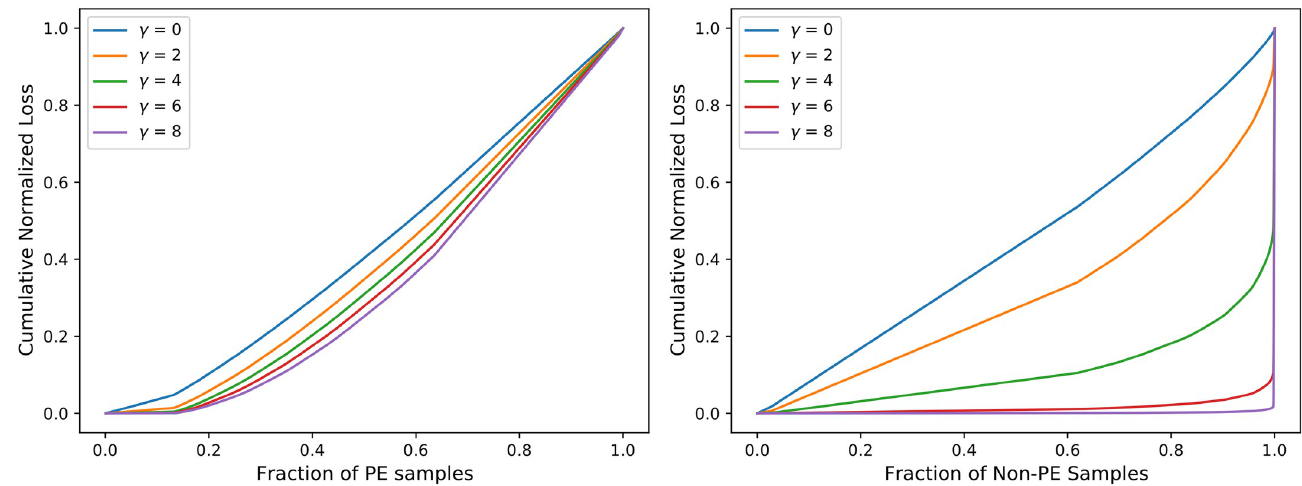
Fig 18. Cumulative distribution functions of the normalized loss for PE (positive) and Non-PE (negative) samples for various γ values for Texas PUDF and α = 0.5.